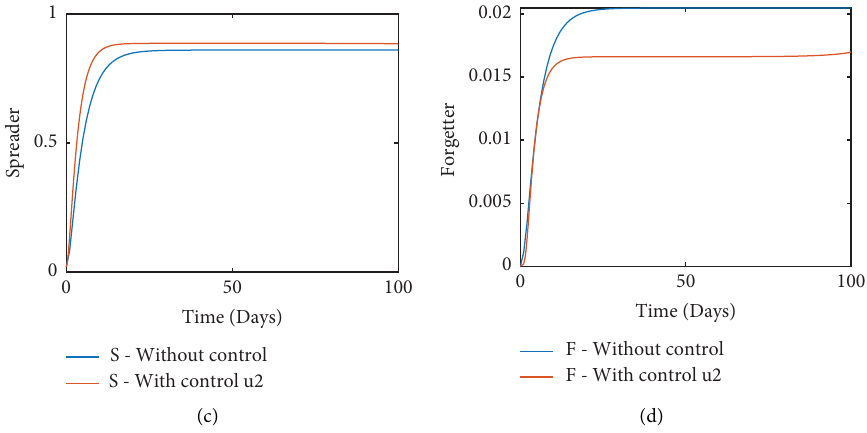
Figure 13: Comparison of population density with u